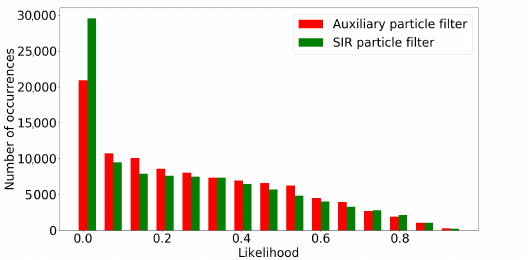
Figure 7. Distribution for the likelihoods of the auxiliary particle filter and the standard particle